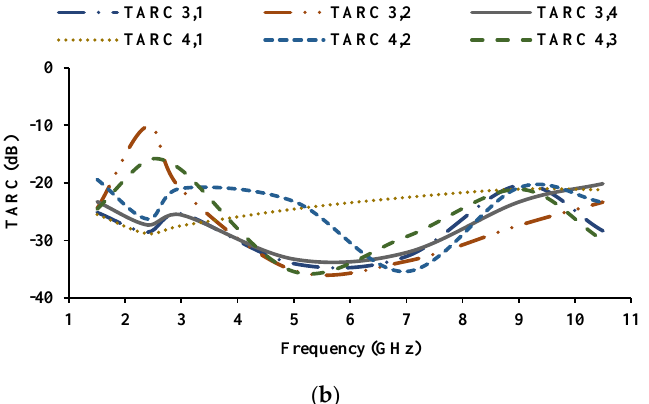
Figure 16. TARC of the proposed antenna ( a ) with respect to port 1 and port 2, ( b ) with respect to port 3 and port 4.